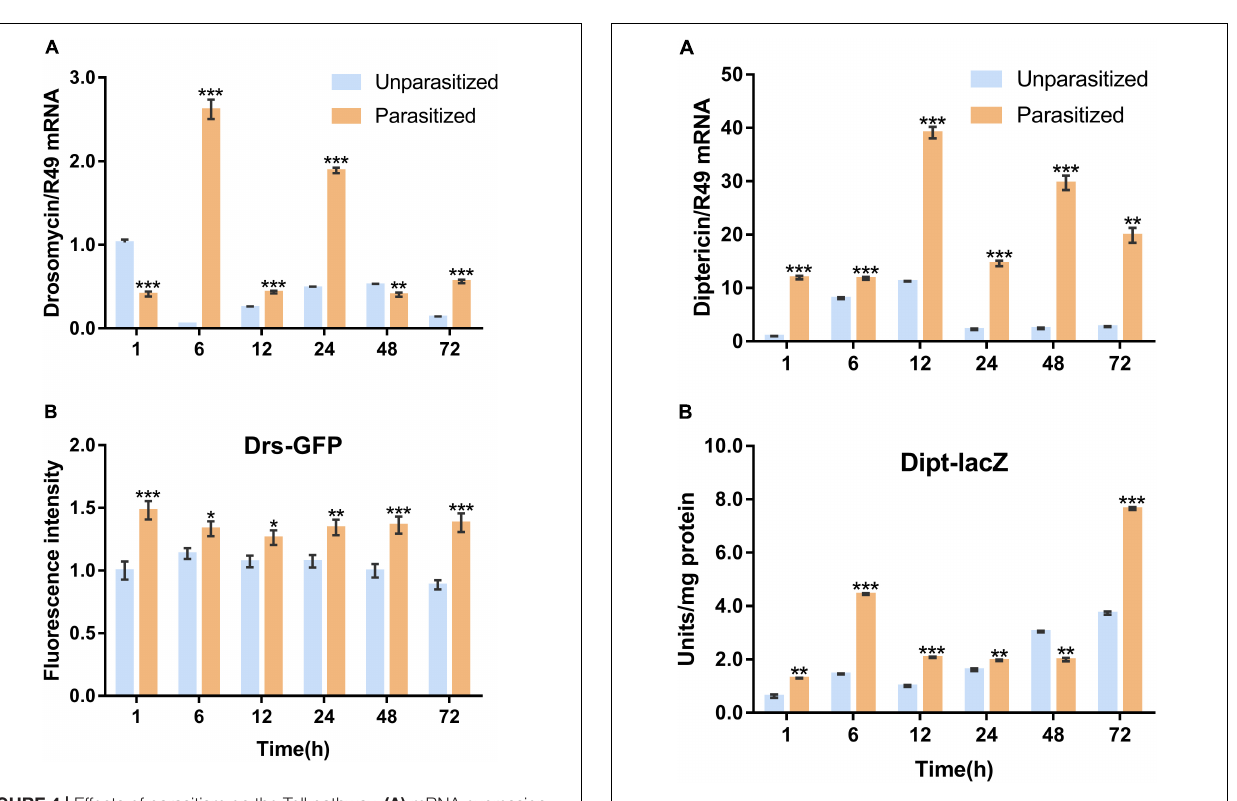
FIGURE 6 | Effects of parasitism on the Imd pathway. (A) mRNA expression levels of diptericin at 1, 6, 12, 24, 48, and 72 h in parasitized and unparasitized Drosophila ( n = 3). R49 was used as internal reference. (B) Enzymatic activity assay of diptericin-lacZ both in parasitized and unparasitized Drosophila based on the time points mentioned above ( n ≥ 10). The enzymatic activity of 1 h unparasitized was normalized to 1. The results are shown as the mean ± standard error; ∗∗ P < 0.01 and ∗∗∗ P < 0.001 compared to